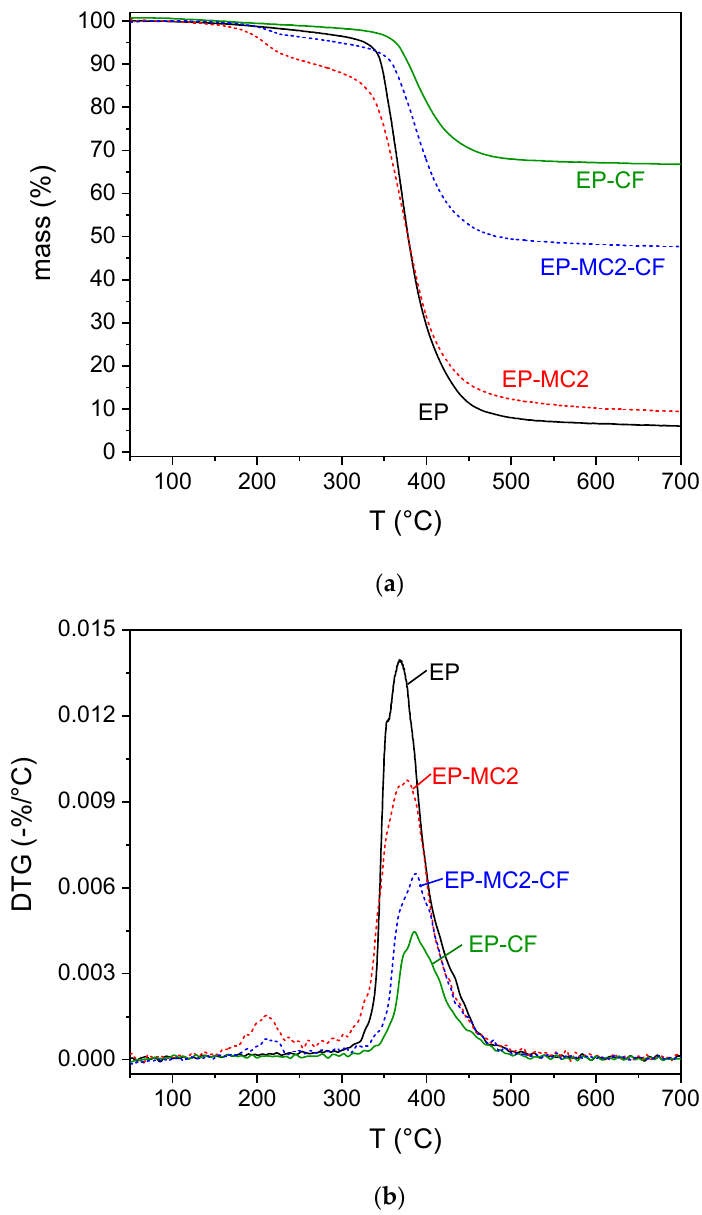
Figure 10. TGA thermograms of the epoxy-based matrices EP and EP-MC2, and on the laminates EP-CF and EP-MC2-CF. ( a ) mass; ( b ) mass loss derivative (DTG). Table 4. Density and weight fraction of the constituents of the epoxy-based matrices and laminates from the TGA and Archimedes’ balance tests.